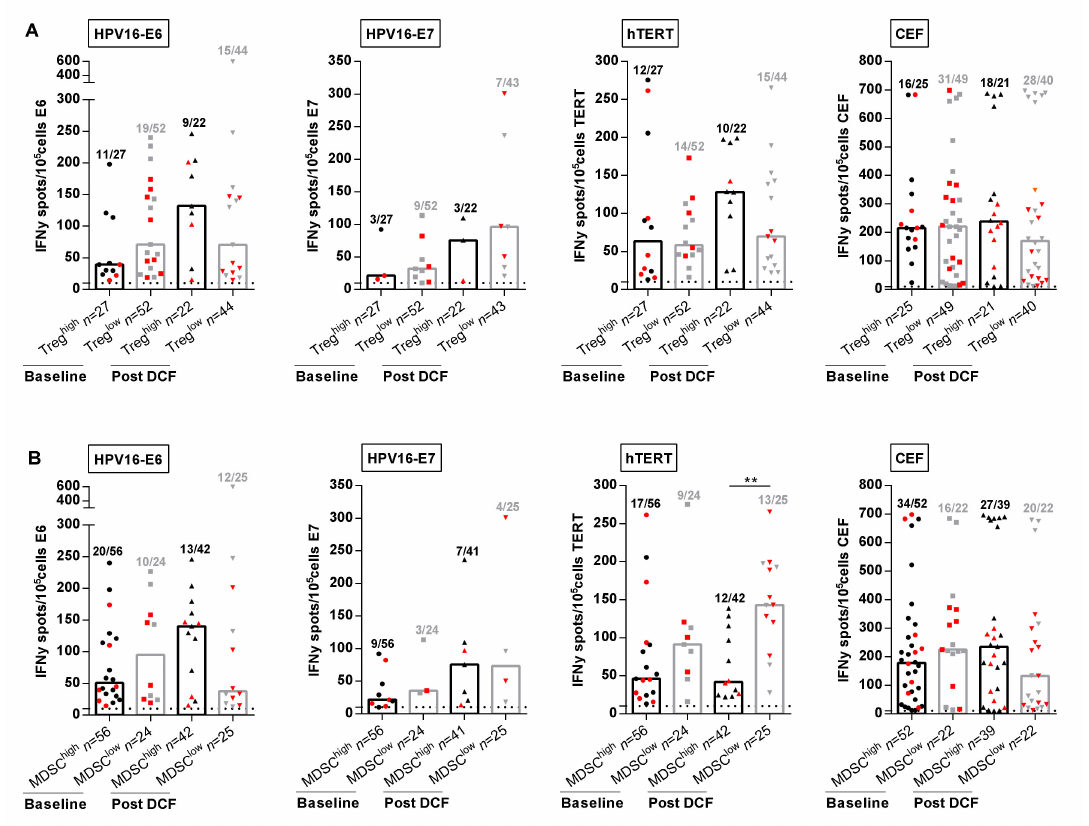
Figure 4. M-MDSC and not Treg levels are correlated with antigen-specific immune responses. ( A , B ) Intensities of positive HPV16-E6-, HPV16-E7-, hTERT- and antiviral-specific T-cell responses in SCCA patients before and after DCF chemotherapy according to Treg levels ( A ) or M-MDSC levels ( B ). Mann Whitney U test, where ** p < 0.01. Red plots represent patients without